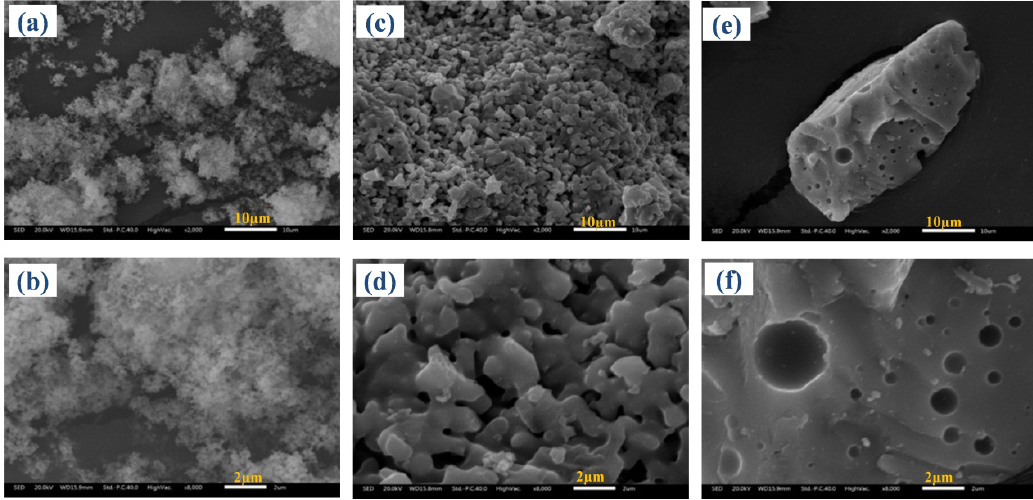
Figure 4. SEM images of raw HB-ASR ( a , b ) and treated HB-ASRs ( c , d ) treated for 120 min, ( e , f ) treated